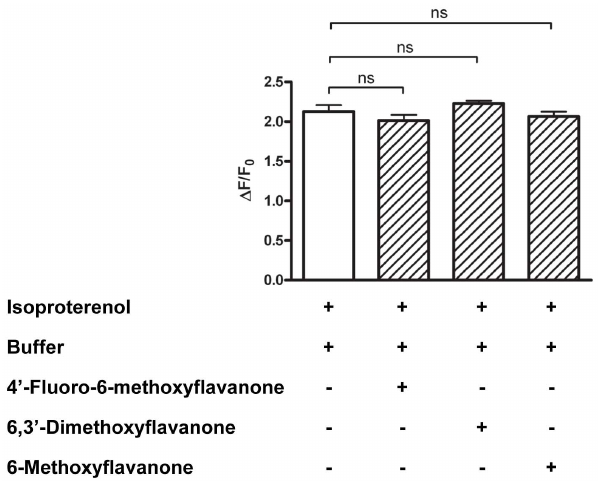
Figure 7. Isoproterenol responses upon application with buffer, 4 9 -fluoro-6-methoxyflavanone (6), 6,3 9 -dimethoxyflava- none (3), and 6-methoxyflavanone (11). Data are presented as mean 6 SEM of a representative experiment conducted in